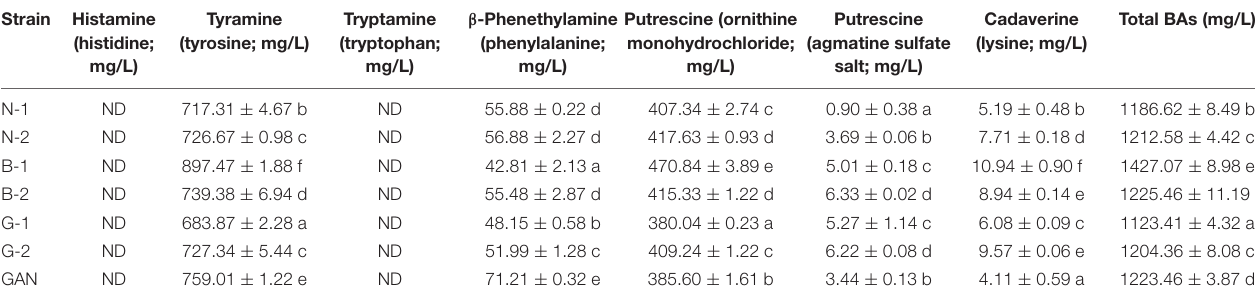
TABLE 4 | The BA-producing abilities of the isolated strains with corresponding precursor. Strain Histamine (histidine;